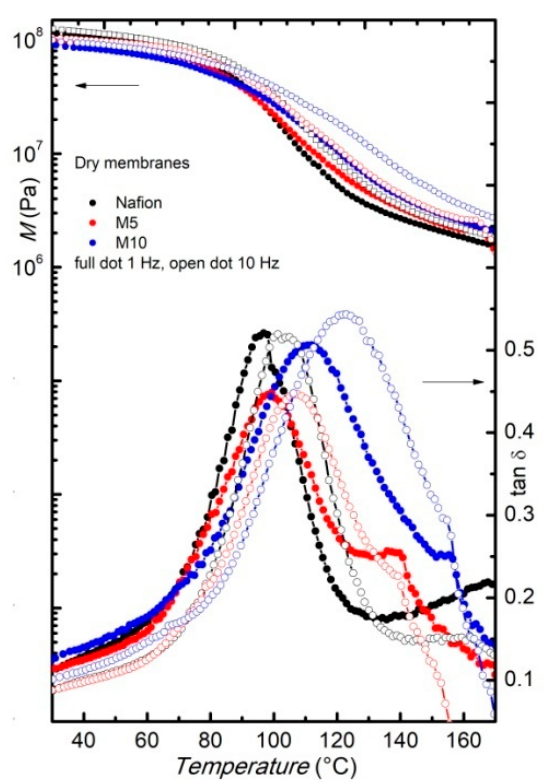
Figure 3. Modulus and elastic energy dissipation of pure and dry Nafion (black) and composite membranes M5 (red) and M10 (blue), measured on heating, at two frequencies, i.e., f = 1 Hz (full dots) and f = 10 Hz (open